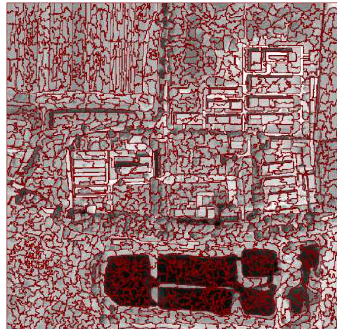
Figure 5 The segmentation result (the number of segments is set to 1500)